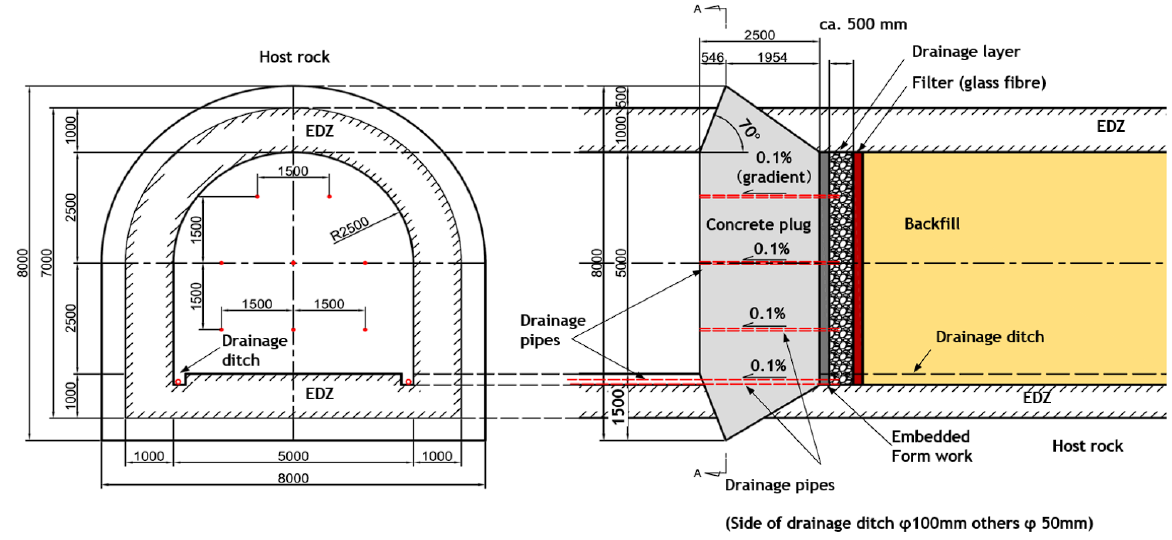
Figure 14. Concrete plug for horizontal tunnel isolation in Japanese geological disposal facility project [58].